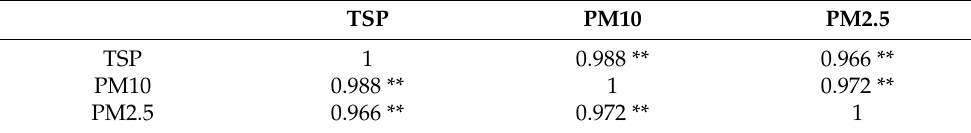
Table 5. Correlation coefficient between PMs.